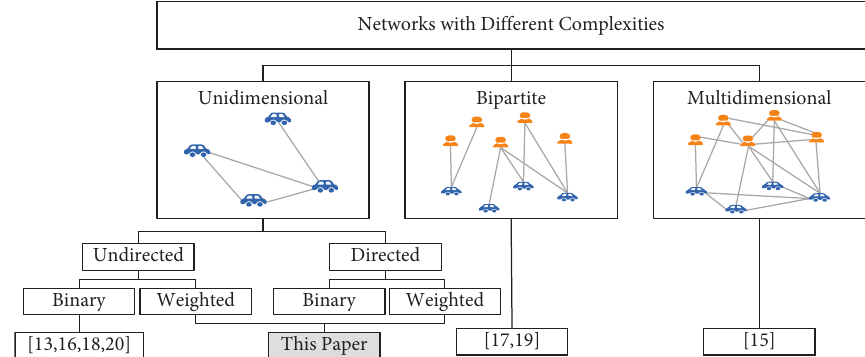
Figure 1: Unidimensional, bipartite, and multidimensional networks in customer-product relation modeling. We show that past work in literature did not address weighted models for directed or undirected networks. This paper fills this gap for unidimensional networks.